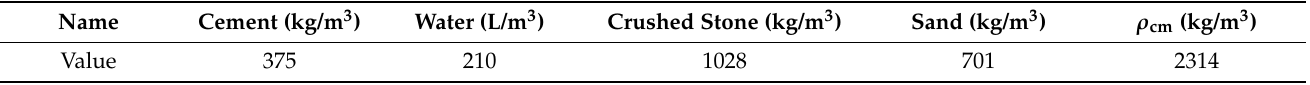
Table 4. Composition of the concrete